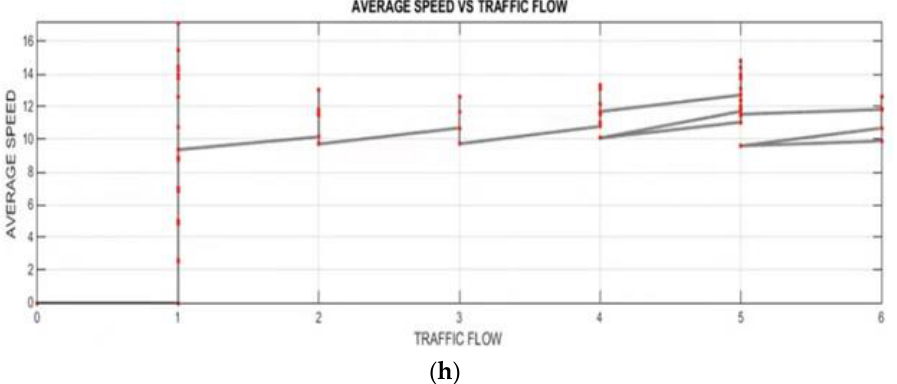
Figure 13. Simulations results for scenario 2, no-LAVs vehicles (from Figure 13a – h). ( a ) Traffic congestion; ( b ) space utilization; ( c ) traffic jam ratio; ( d ) time mean speed; ( e ) harmonic mean; ( f ) simulation results for TMS vs. SMS during the whole time; ( g ) simulation results for scenario 2 average speed vs. traffic density; ( h ) simulation results for scenario 2 average speed vs. traffic flow.